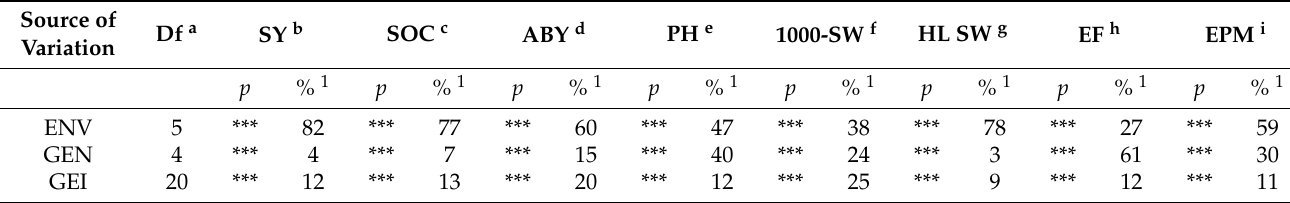
Table 3. Joint ANOVA ( p -value) and variance explained (%) by environment (ENV), genotype (GEN) and GEI for the eight studied traits. Source of